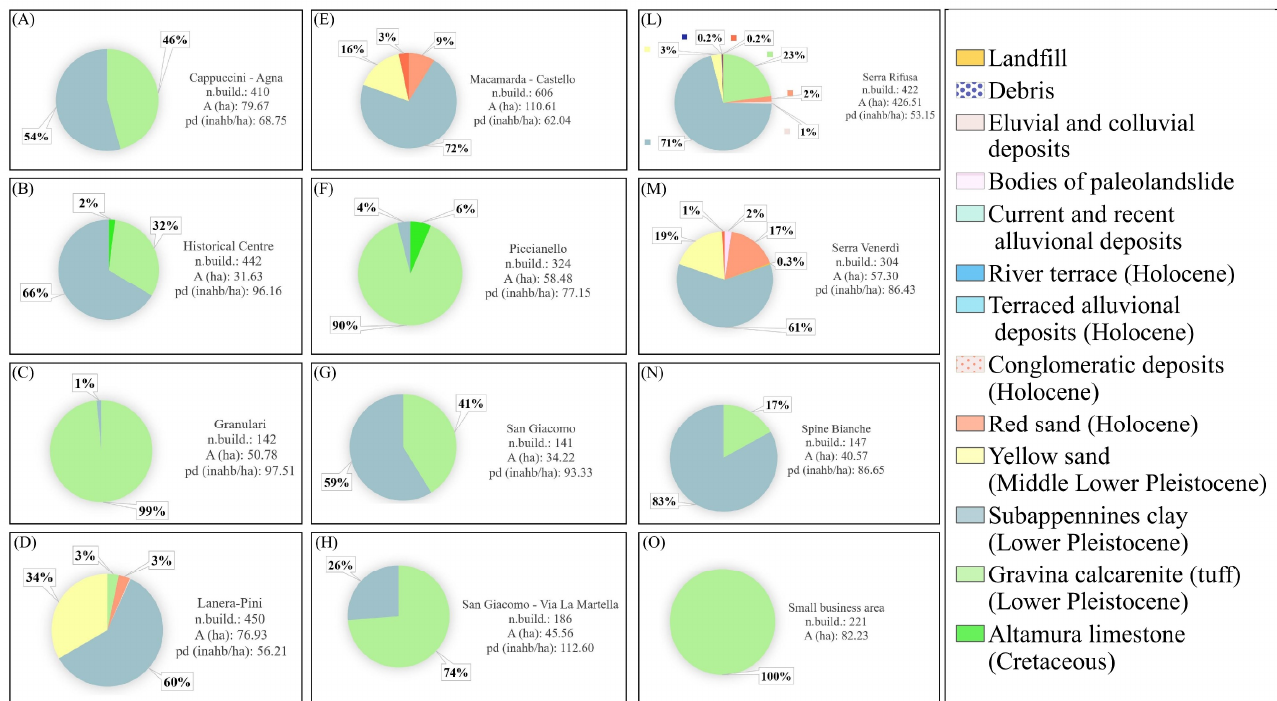
Figure 6. ( A – O ) Pie charts showing proportions (as percentages) of major foundation soil geology for each macro-area. Every diagram reports the macro-area name, the number of buildings (n.build.), the extension of the area in hectares (A(ha)), and the population density expressed as inhab/ha (pd).